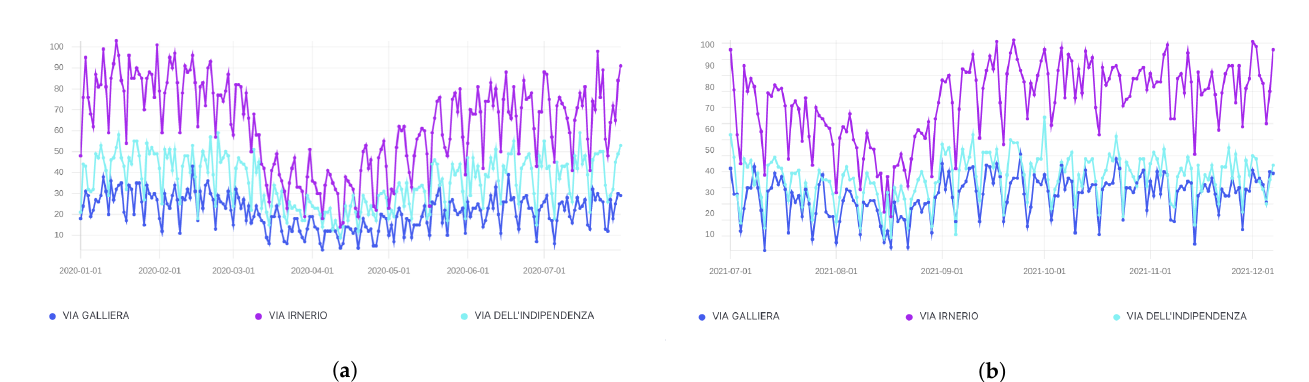
Figure 5. Trend of the vehicular index—scale [0, 100] for better visualization—in the pre-COVID-19, during and post- COVID-19 period. ( a ) Timeline comprising the COVID-19 period. ( b ) Post-COVID-19 period.